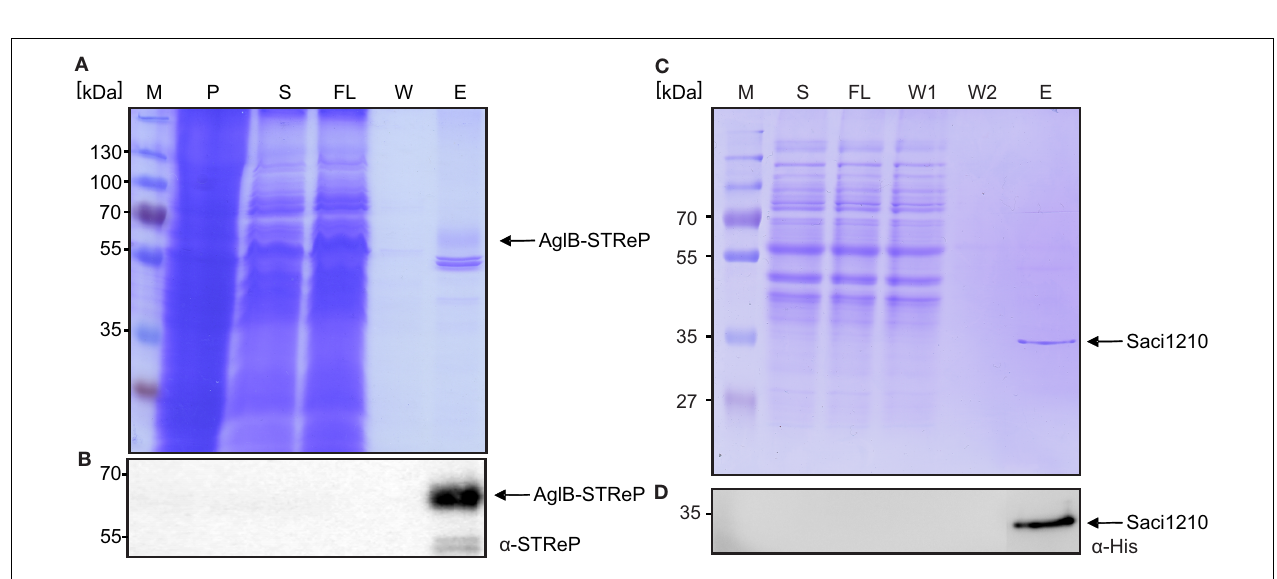
FIGURE 4 | Insertion and expression of the S. solfataricus ABC glucose transporter in the S. acidocaldarius genome. (A) Depiction of the genomic integration of the glucose ABC transport operon of S. solfataricus in the upsE locus in the S. acidocaldarius genome.The signal peptide of GlcS, the glusoce binding protein, was exchanged by the MalE